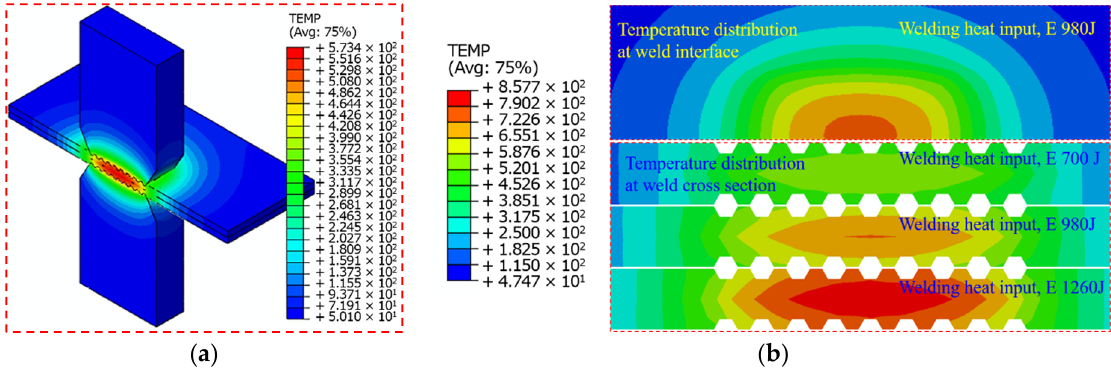
Figure 17. Temperature distribution at different welding heat inputs for the 3D plot ( a ) and xy plot ( b ) .